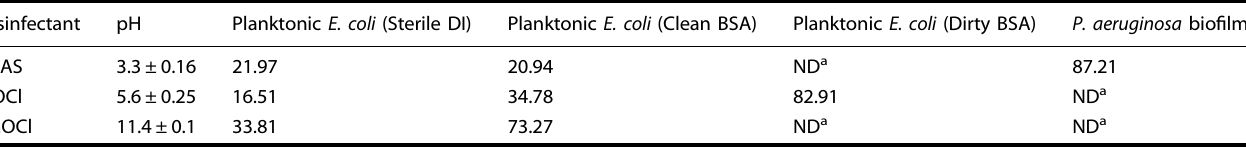
FC concentrations were determined by linear regression, and contact time was 5 min for all reactions. a Refer to CT values (mgmin L − 1 ) unable to be calculated under experimental conditions where log reductions were not met under contact